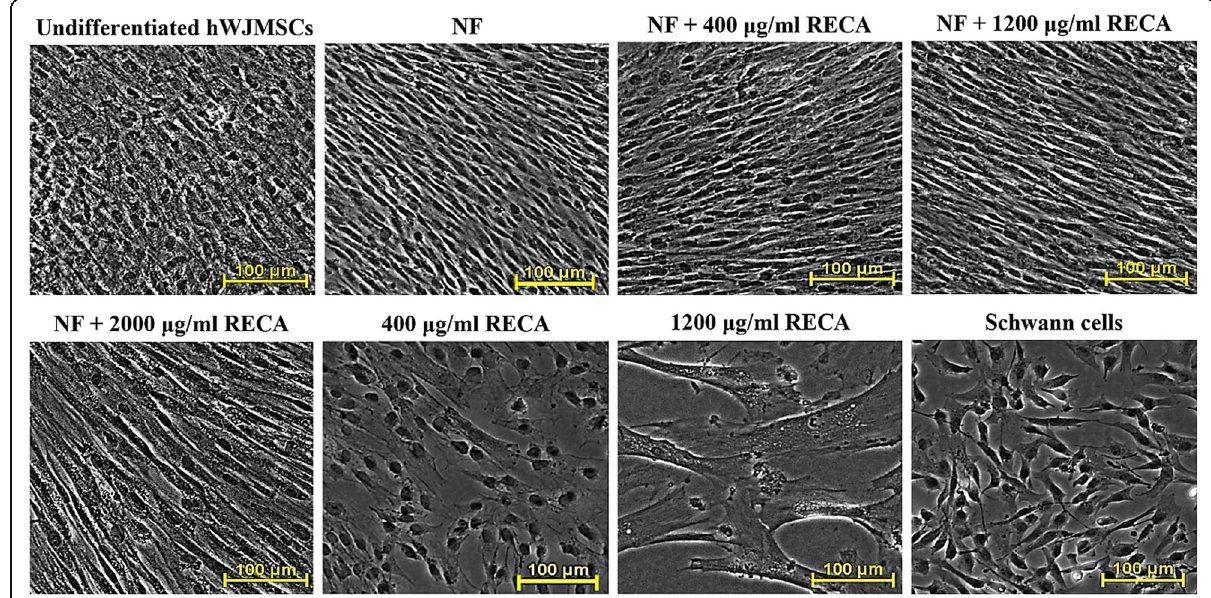
Fig. 7 Morphological changes to hWJMSCs after 9 days of neural induction in different treatments. The undifferentiated hWJMSCs served as negative control, with Schwann cells as the positive control. Differentiated hWJMSCs in NF and all NF + RECA groups displayed a spindle-like cell morphology. A reduction in cell number was detected in the presence of RECA and cell enlargement was clearly noted with an increase in the RECA concentration ( n = 6). NF; neurotrophic factors. Scale bar 100 μ